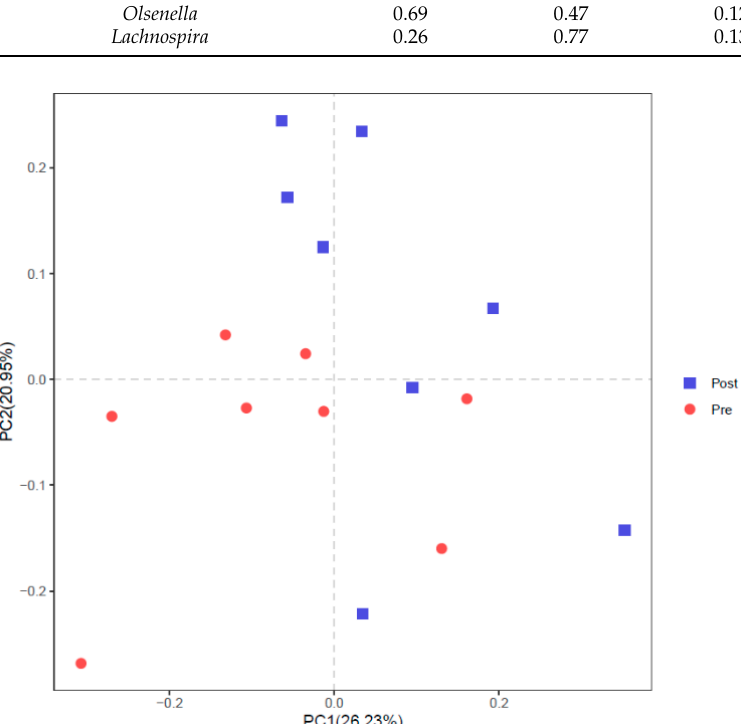
Figure 5. Principal coordinates analysis (PCoA) of rumen bacterial community before (Pre) and after (Post) diet shift.